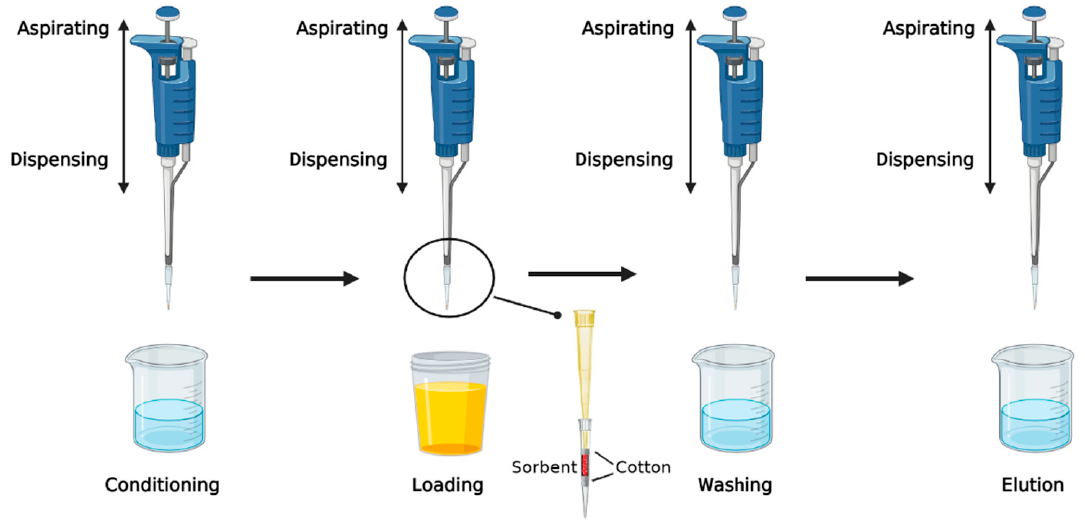
Figure 1. A scheme of the PT-SPE procedure.